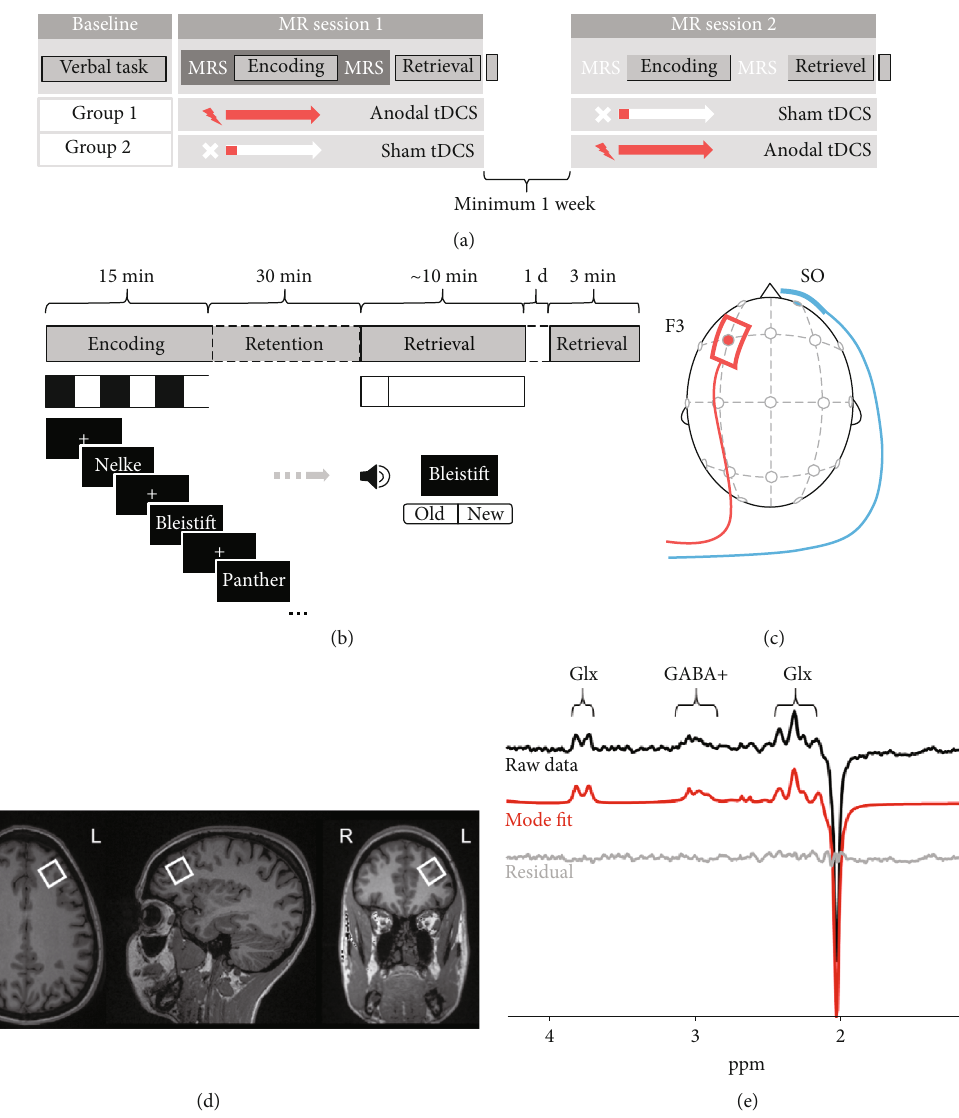
Figure 1: Experimental setup. (a) Study procedure during three experimental sessions. Baseline: assessments of initial cognitive task performance. MR sessions: verbal episodic memory task while receiving either sham or real anodal tDCS during encoding phase inside